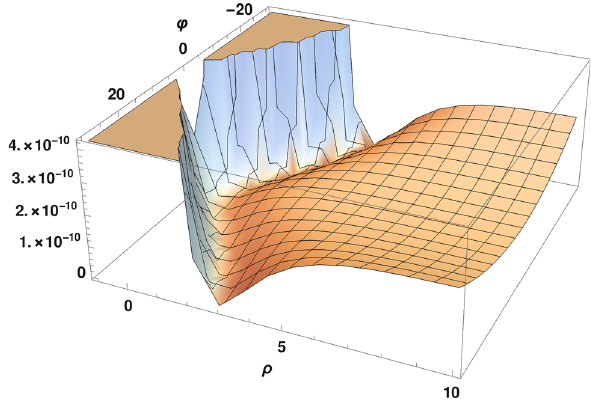
Fig. 1 The potential V (φ,ρ) for α = 0 . 01 , β = 0 . 001 and M = 1 . 3 · 10 −